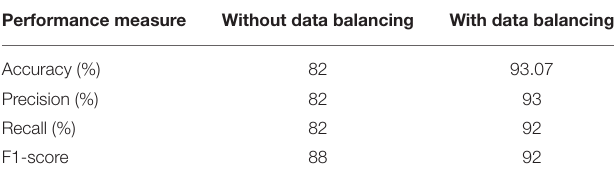
TABLE 3 | Performance of the BILSTM models with and without balancing